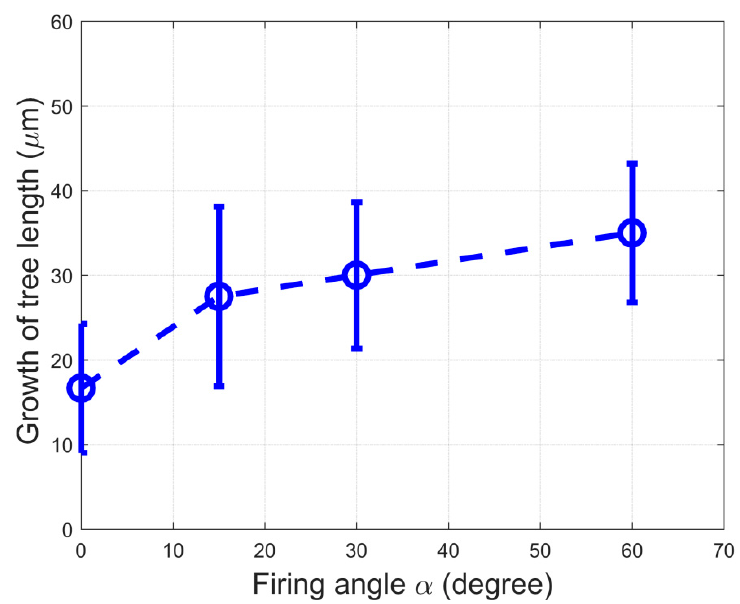
Figure 10. Growth of tree length against the firing delay angle at positive voltage.